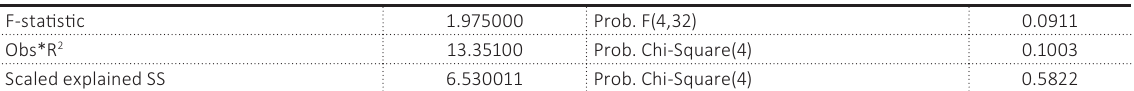
Source: Extracted from result outputs.